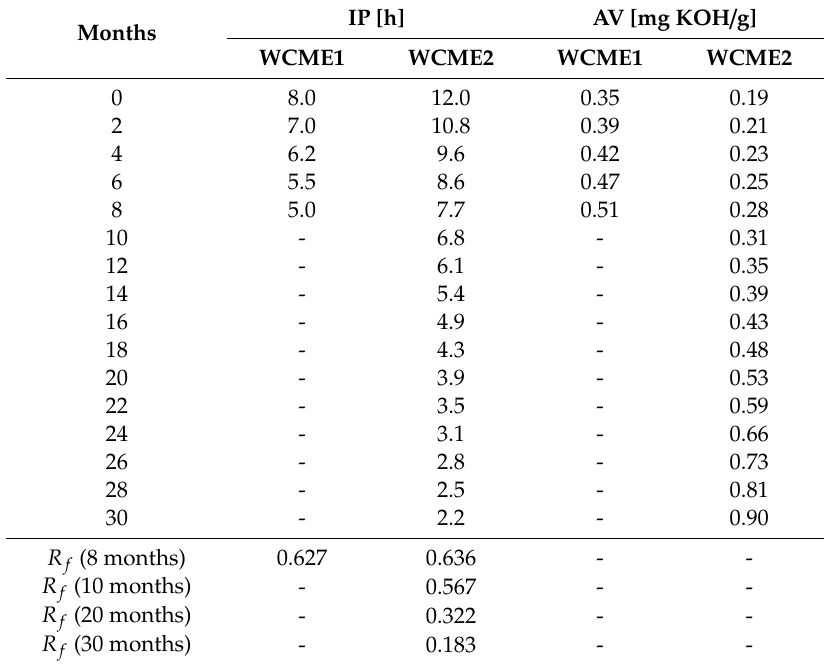
Table 6. Influence of storage time (months) and temperature on the induction period and acid value of WCME1 and